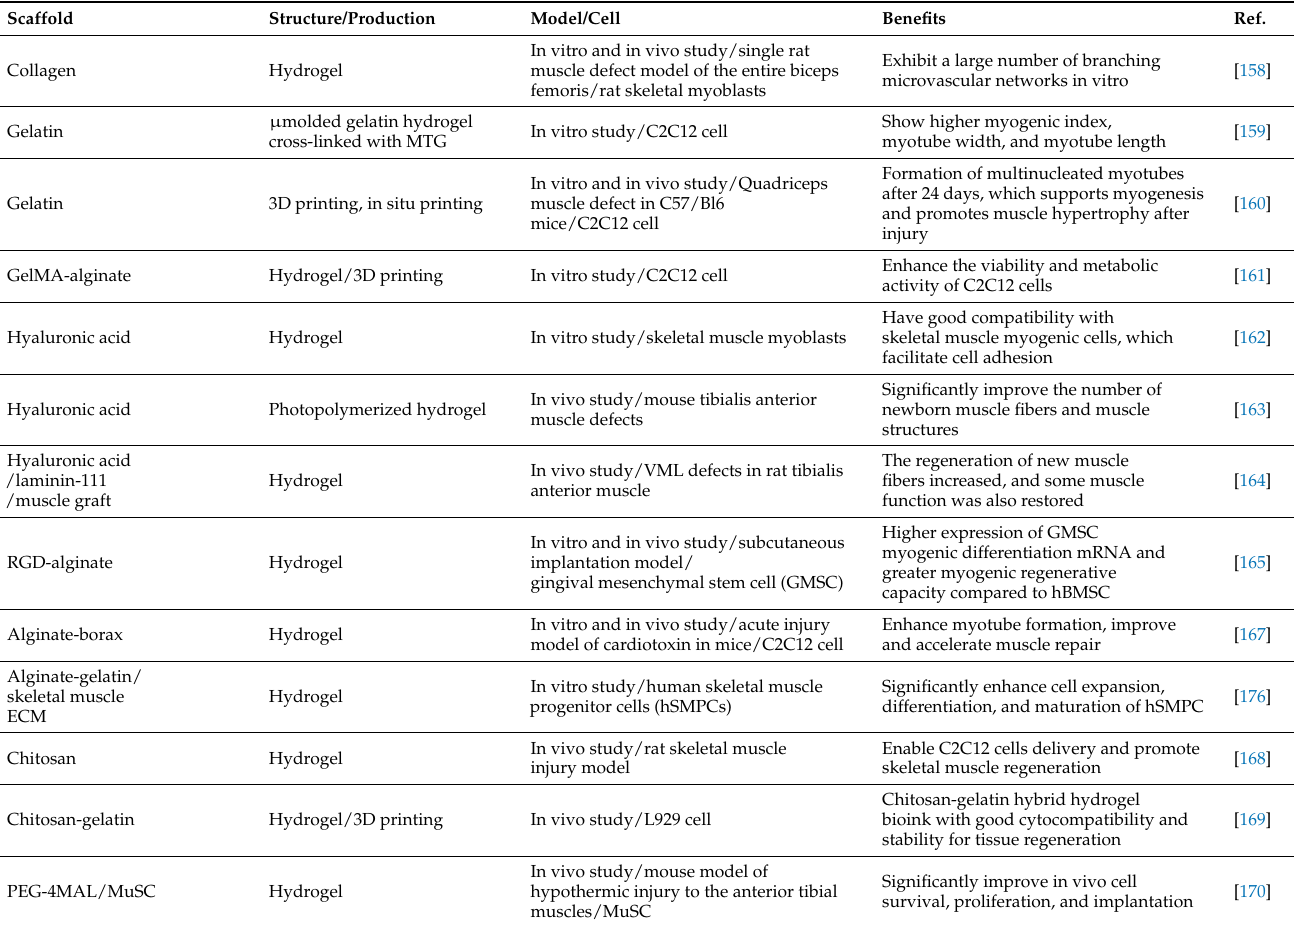
Table 2. Summary of recent studies on polymer-based hydrogel materials in skeletal muscle tissue